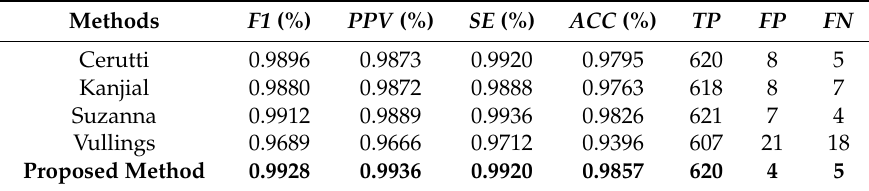
Table 2. FECG QRS detected from statistical assessment of signal r07